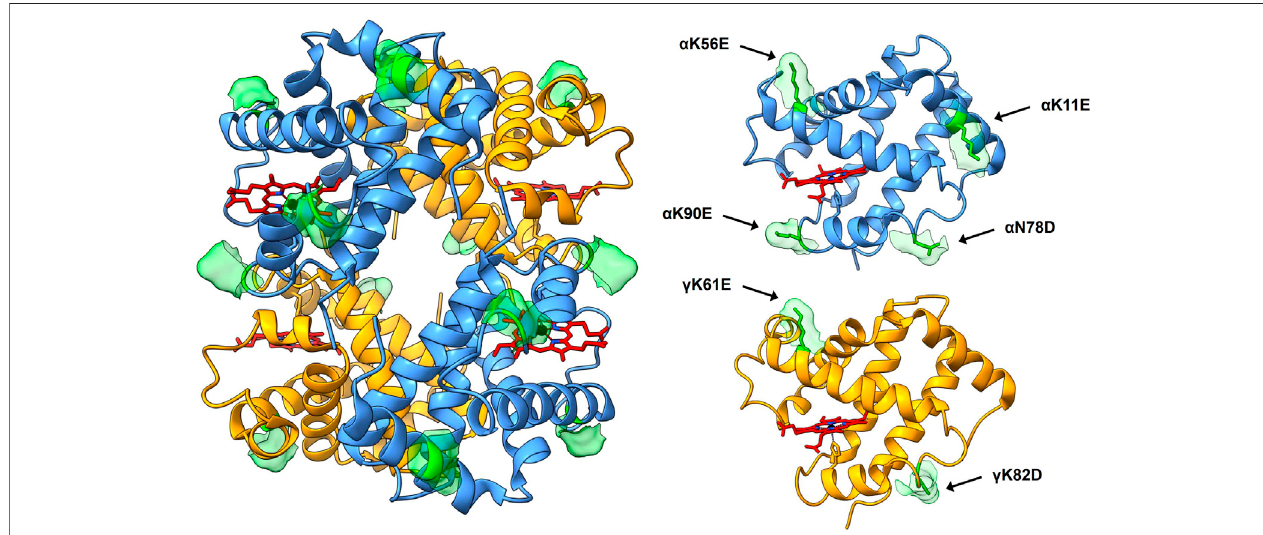
FIGURE 1 | 3D structure of HbF (PDB code 1FDH (Frier and Perutz 1977)). The full tetramer structure is shown to the left, with the peptide backbone depicted as ribbons. α -subunitsarecoloredblue, c -subunitsyellow,andhemegroupsareshownasstick fi guresinredwithbluenitrogenandblackironatoms.Themutationsitesof the HbF mutants created in this work are shown in green, accompanied by the corresponding solvent-accessible surface patch to highlight the sites. To the right, the α - and c -subunit are shown for clari fi cation of the positioning of the mutation sites. The fi gure was created in the UCSF Chimera molecular visualization program (Pettersen et al., 2004; Goddard et al.,